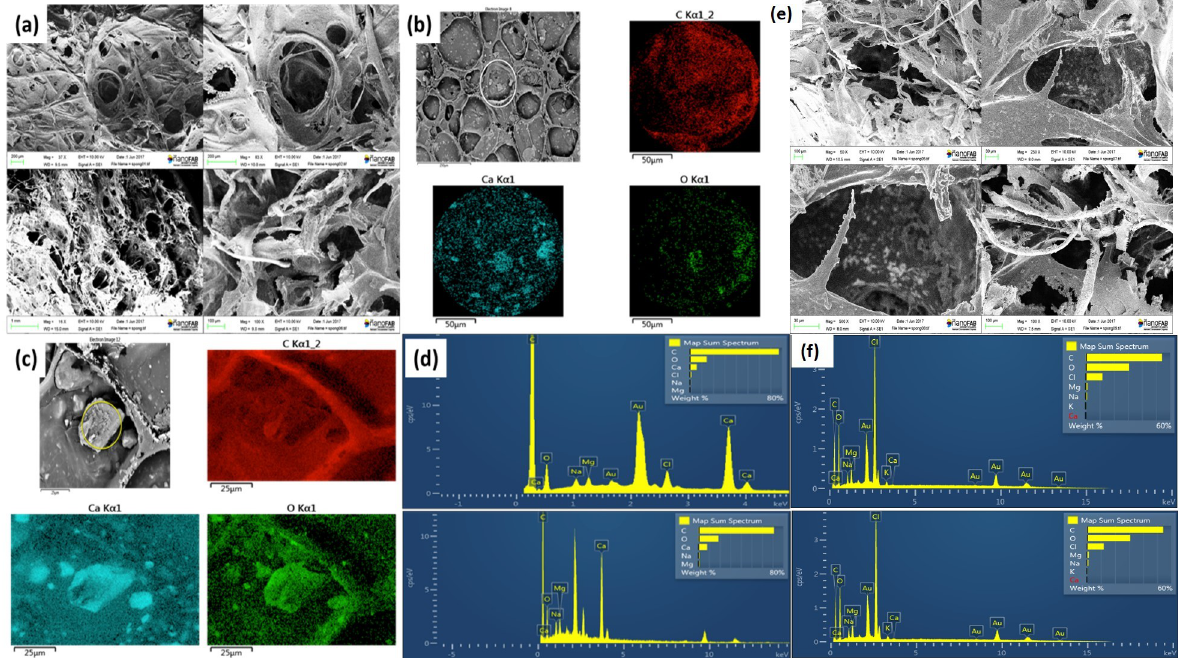
Fig 5. SEM and EDX of the porous medium matrix and the precipitated crystals. (a) Structure of the pore network as imaged under SEM. (b)-(c): Targeted chemical characterization on two pin-pointed locations via EDX. (d) Elemental maps corresponding to (b) and (c) confirming the presence of the signature elements in calcite. (e) The pore network for a similar set of samples immersed in culture medium minus cells. No precipitation detected. (f) Elemental maps show the absence of Ca. The Cl-signals originate from the NaCl in the culture medium. The Au-signals originate from the sputtered gold layer on the